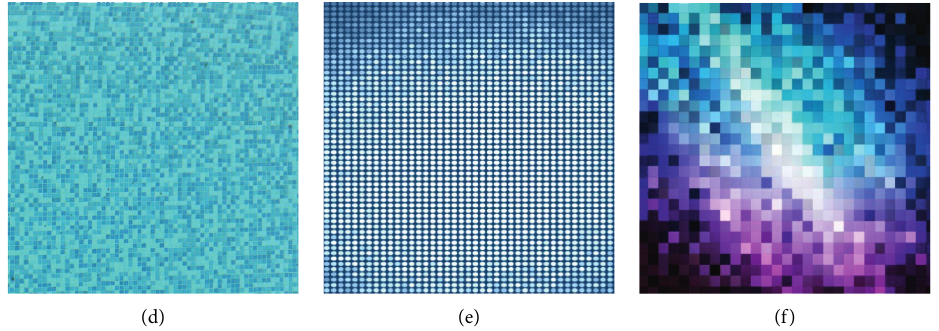
Figure 4: Comparison of encryption effects of different encryption algorithms. (a) 4 ∗ 4 mod2 56s. (b) 8 ∗ 8 mod 256. (c) 16 ∗ 16 mod 256. (d) 4 ∗ 4 mod 256 scrambling. (e) 8 ∗ 8 mod 256 scrambling. (f) 16 ∗ 16 mod 256 scrambling.